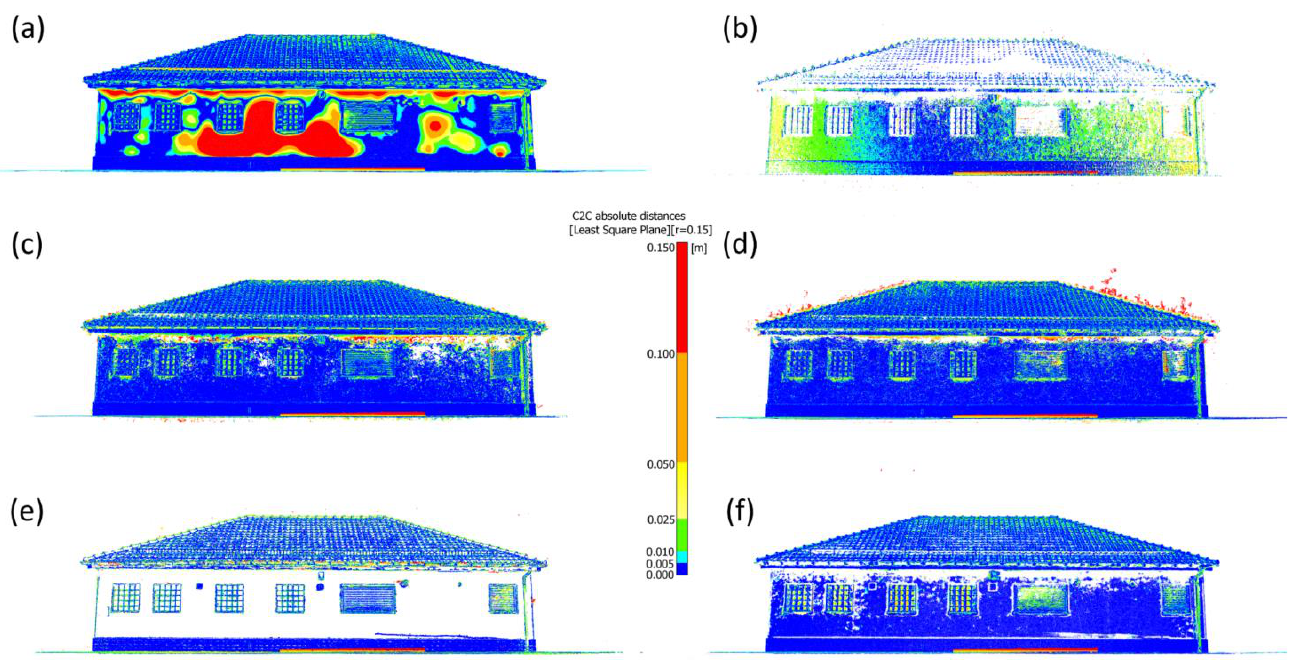
Figure A6. Comparison of TLS and image-based point clouds of elevation 4: ( a ) ContextCapture; ( b ) GRAPHOS; ( c ) Metashape; ( d ) PhotoScan; ( e ) Pix4DMapper; ( f ) RealityCapture.